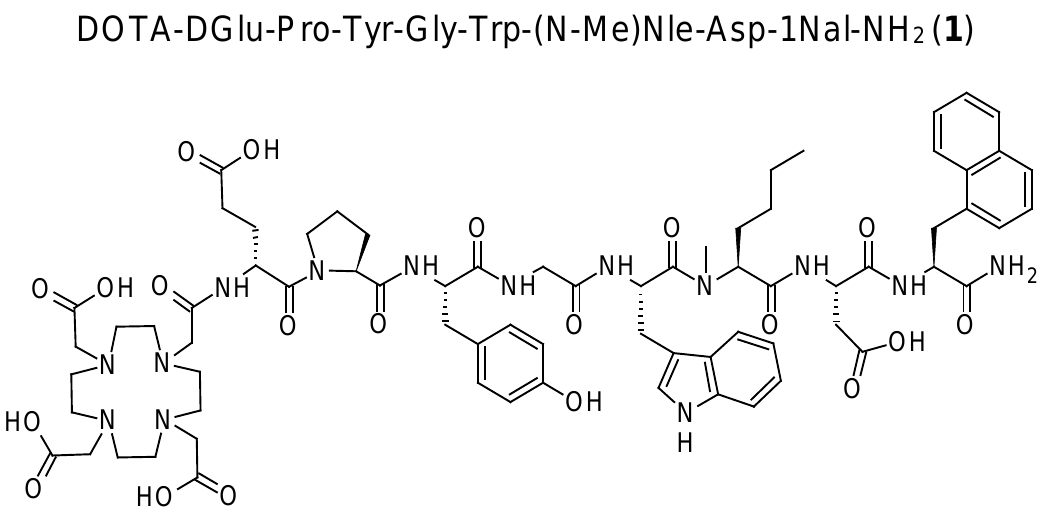
Figure 1. Amino acid sequence and chemical structure of 1 .